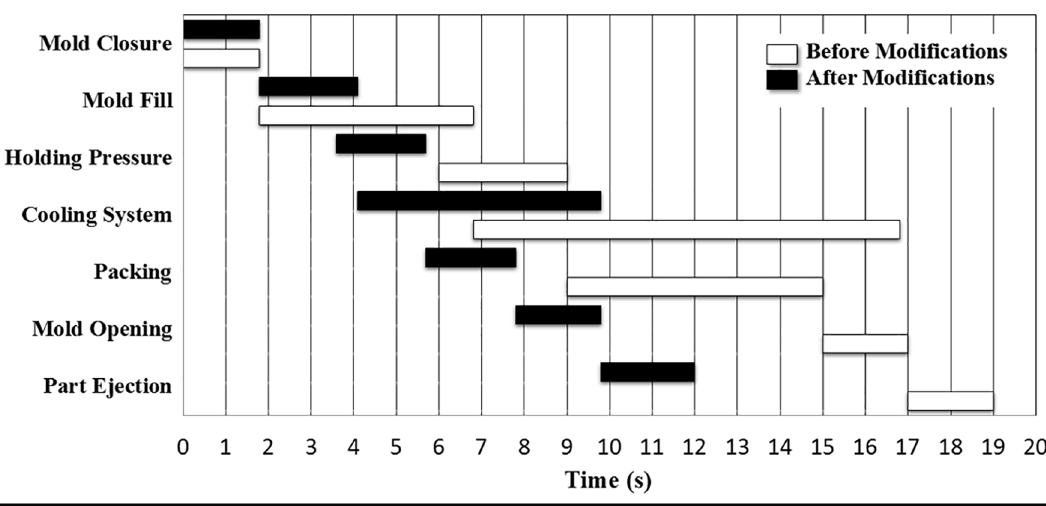
Figure 13. Time spent by the steps of the injection cycle before and after the mold